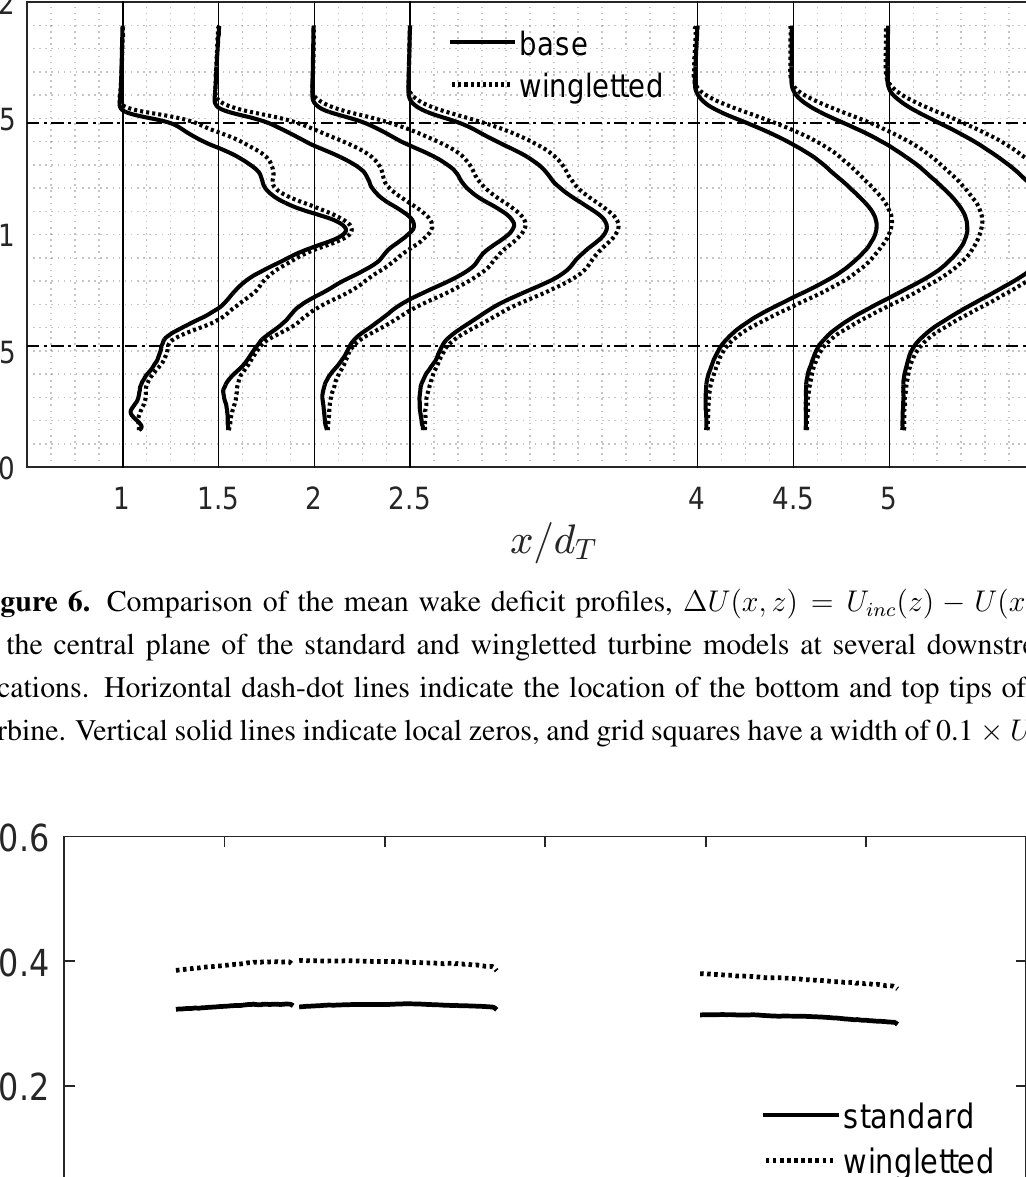
for the two turbine cases as a hub